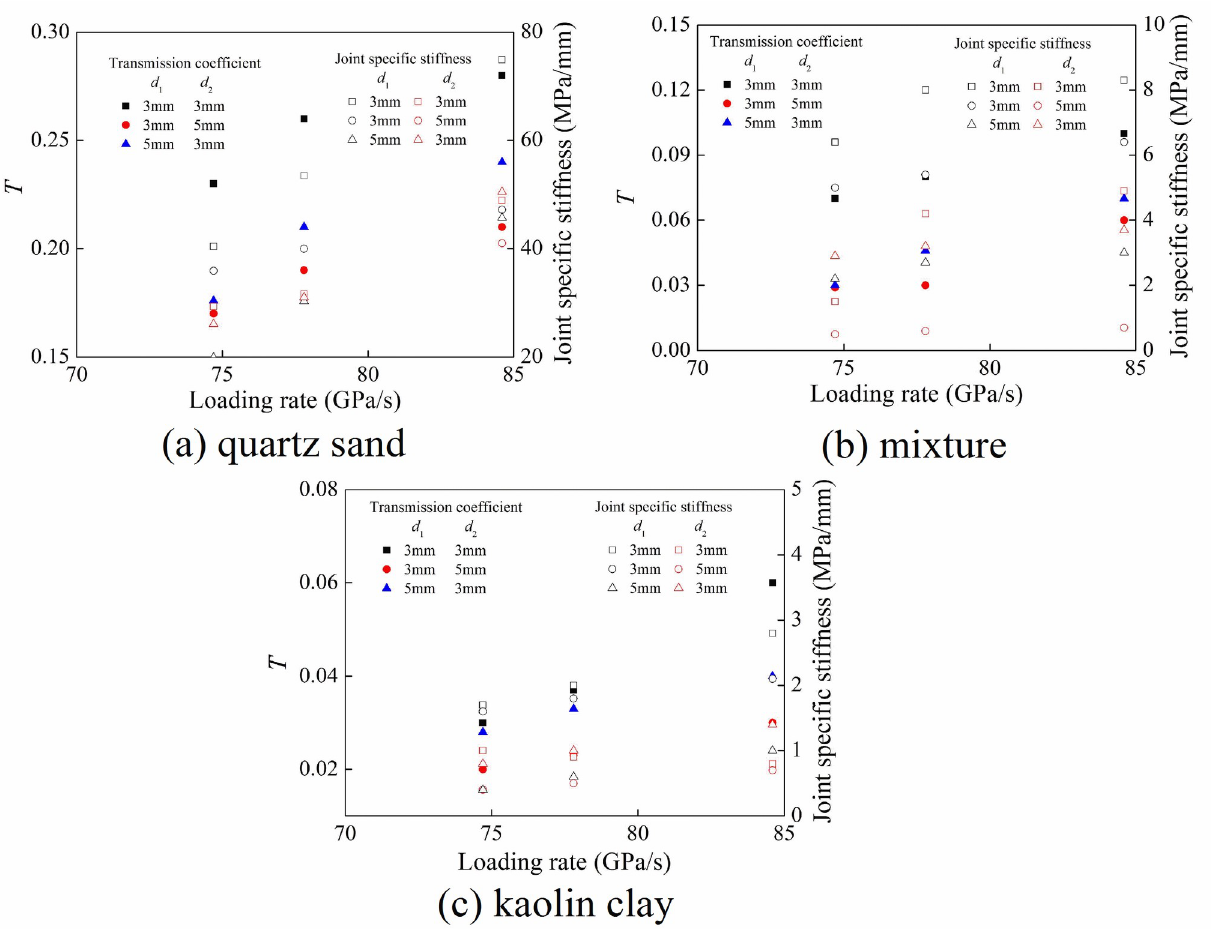
Fig 18. Variation of transmission coefficient with the loading rate. (a) quartz sand (b) mixture (c) kaolin clay.